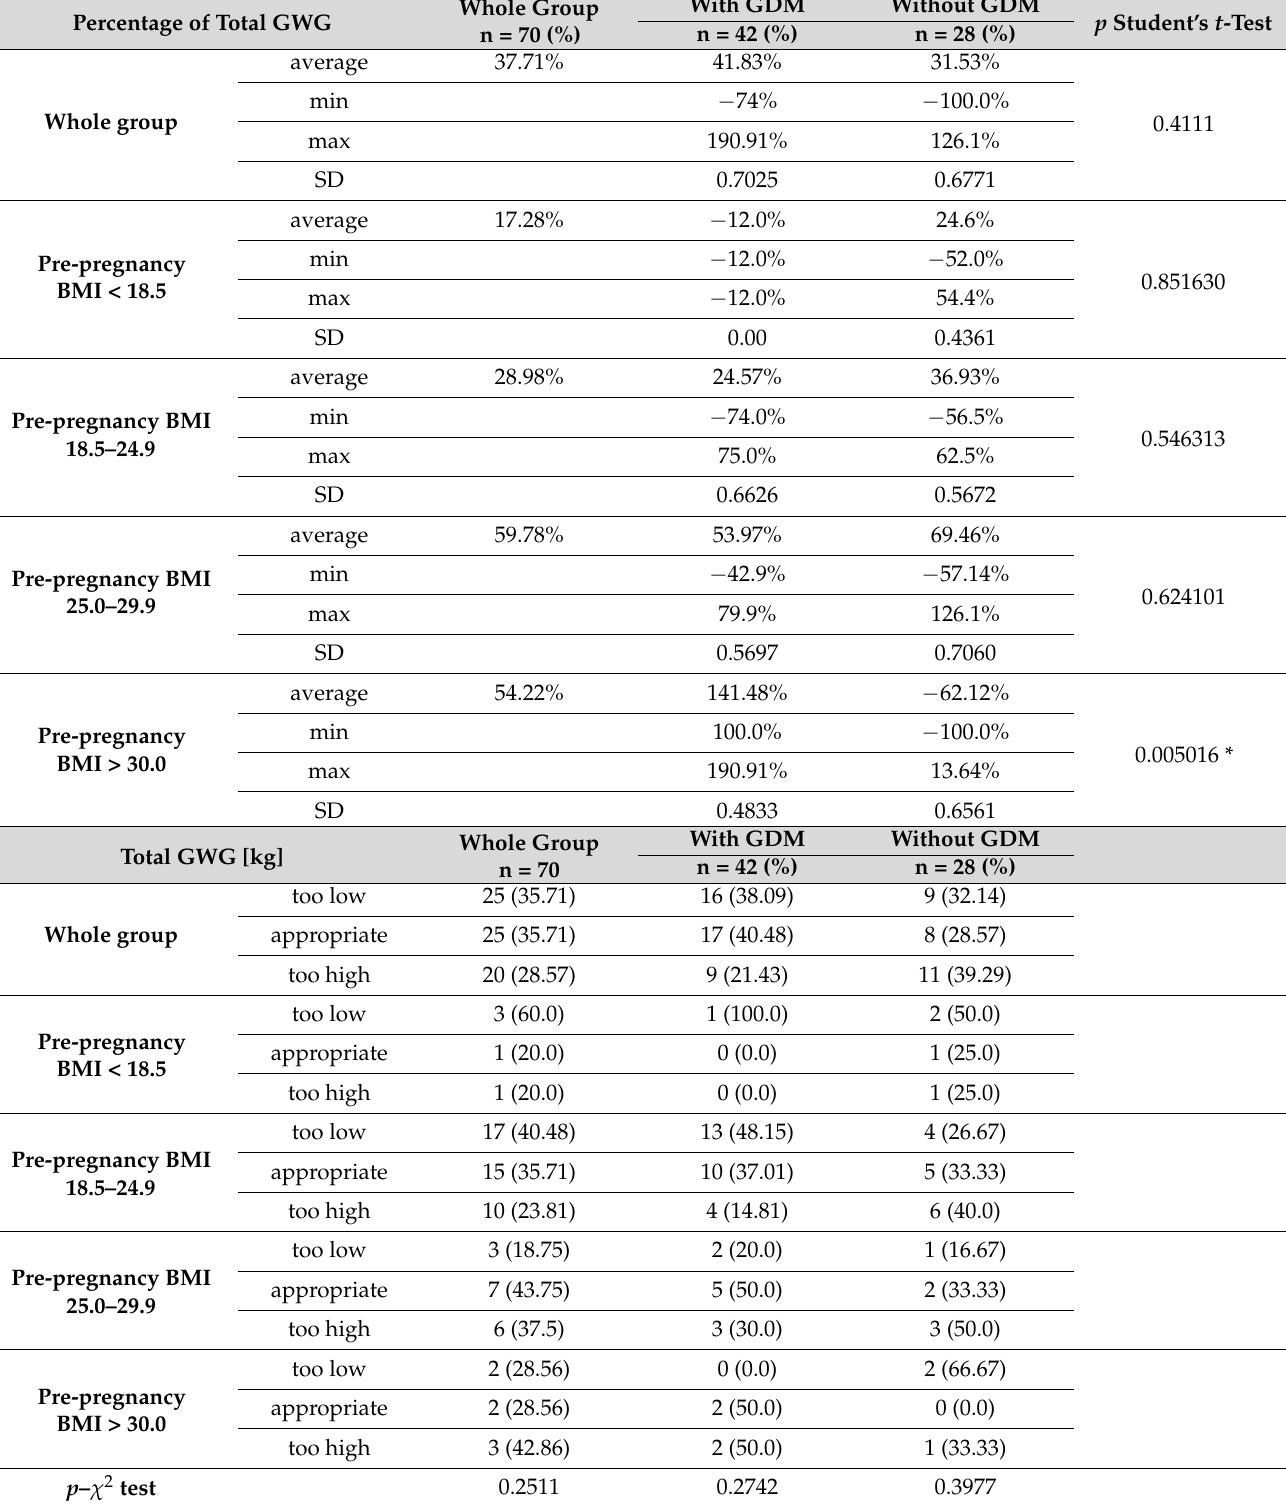
Table 5. Total GWG [kg] and the percentage of total GWG in relation to a pre-pregnancy